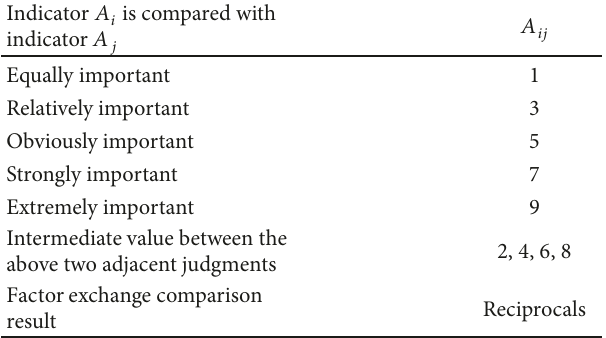
Table 2: Numerical scale